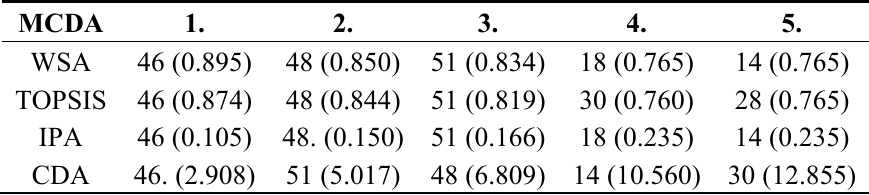
Figure 7. Environmental indicators of material compositions of above-the-ground floor constructions. Table 8. Final MCDA scores for environmental evaluation of above-the-ground floor structures.